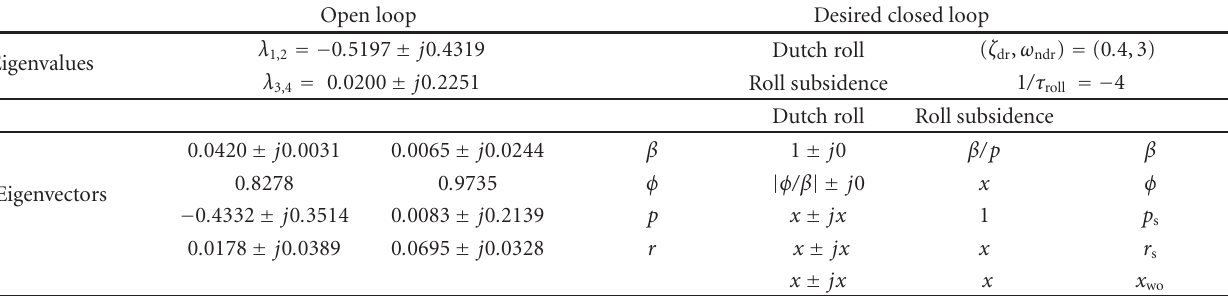
Table 1: Eigenvalues and eigenvectors for the lateral dynamics a